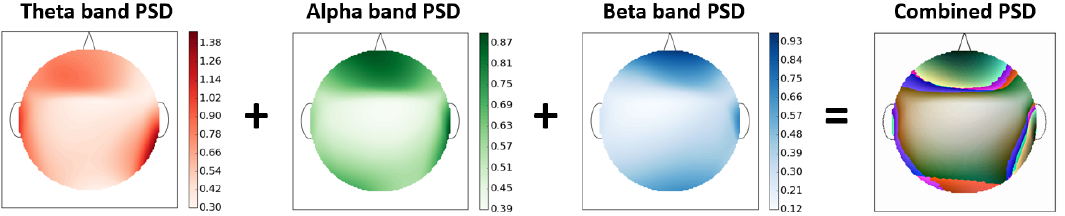
Figure 1. PSD heat-maps of the three EEG bands i.e., theta (red), alpha (green), and beta (blue) EEG bands are added according to respective color-bar range to get combined RGB heat-map image.(Circular outline, nose, ears, and color-bars were added for visualization only. All units are in Watt per